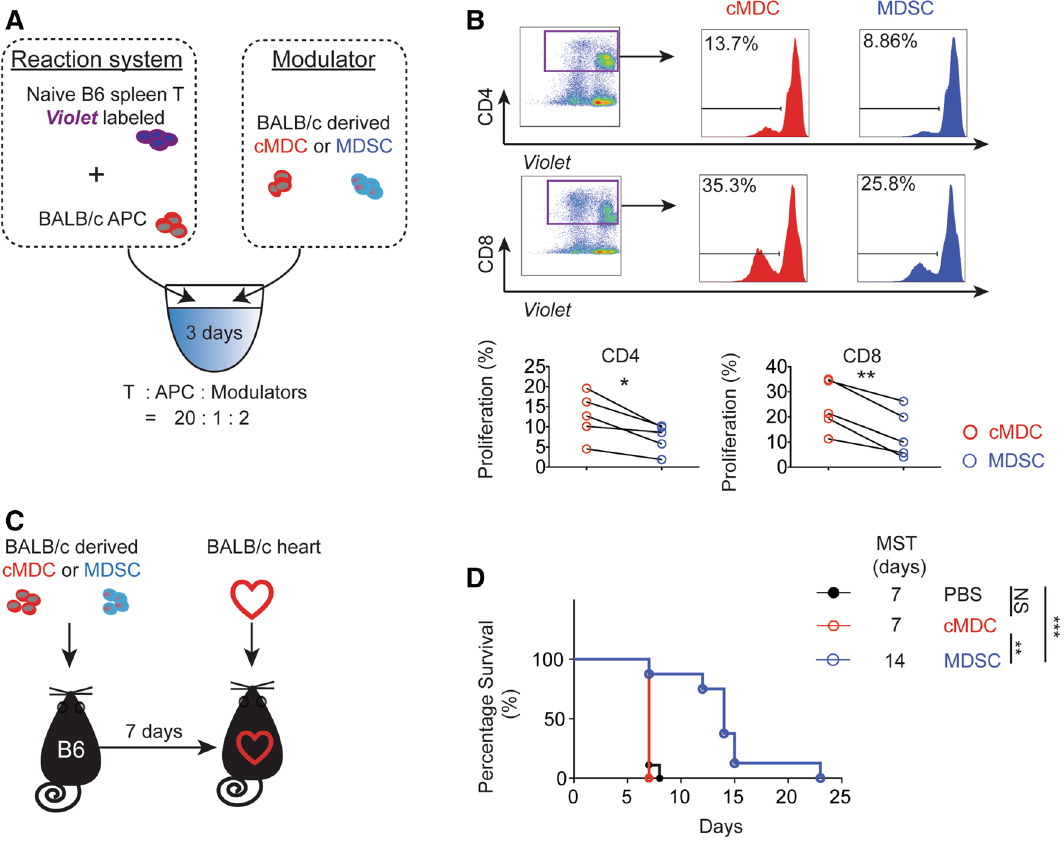
CD8 + T cells in the presence of MDSCs compared to cMDCs. Mean ± SEM, *p < 0.05, **p < 0.01, two-tailed